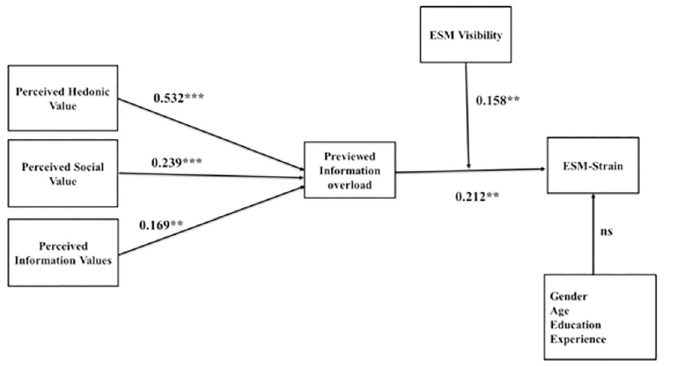
Fig 2. Structural model. Note: � p < 0.05, �� p < 0.01, ��� p <